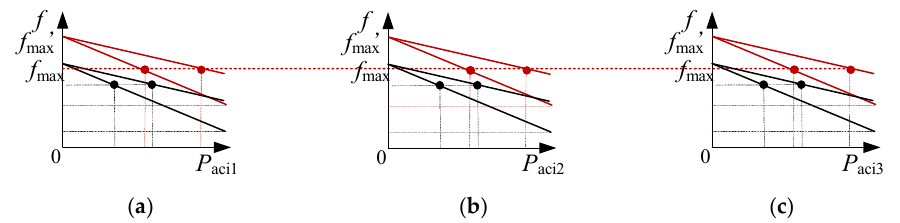
Figure 11. P-f curve in a NMGs under normal operation conditions, ( a ) MG1, ( b ) MG2, ( c ) MG3.